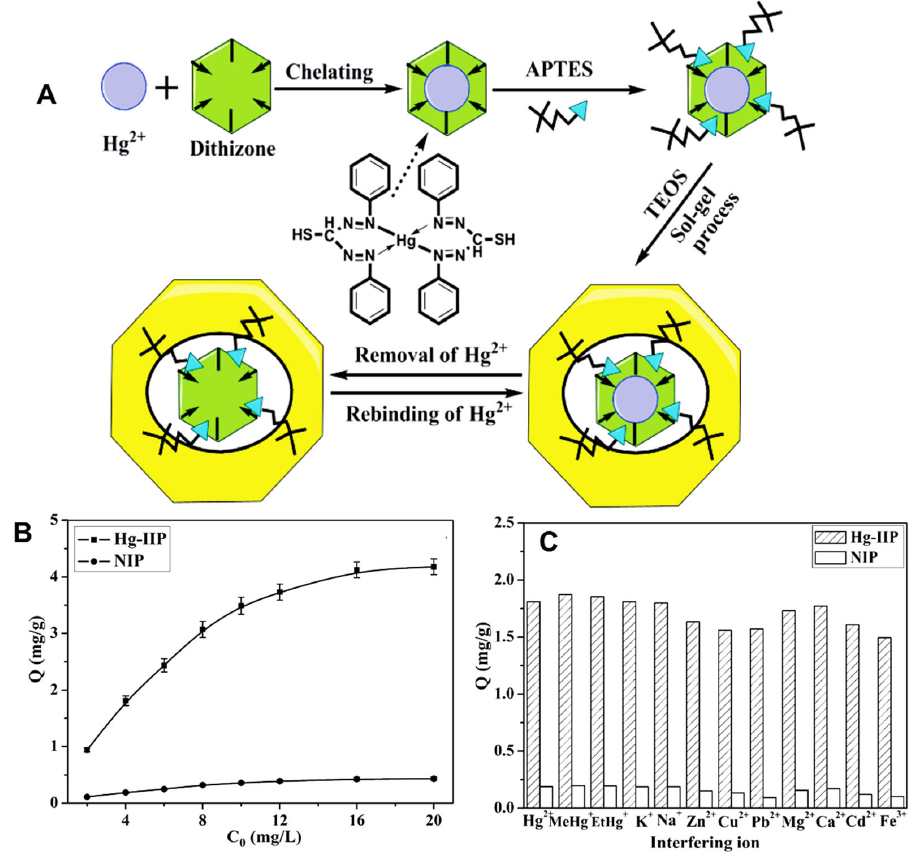
Figure 12. ( A ) Schematic illustration of Hg(II) ‐ IP preparation; ( B ) Adsorption isotherm curves of IIPs and NIPs for Hg(II) in aqueous solutions; ( C ) Adsorption capacities for Hg(II) in the